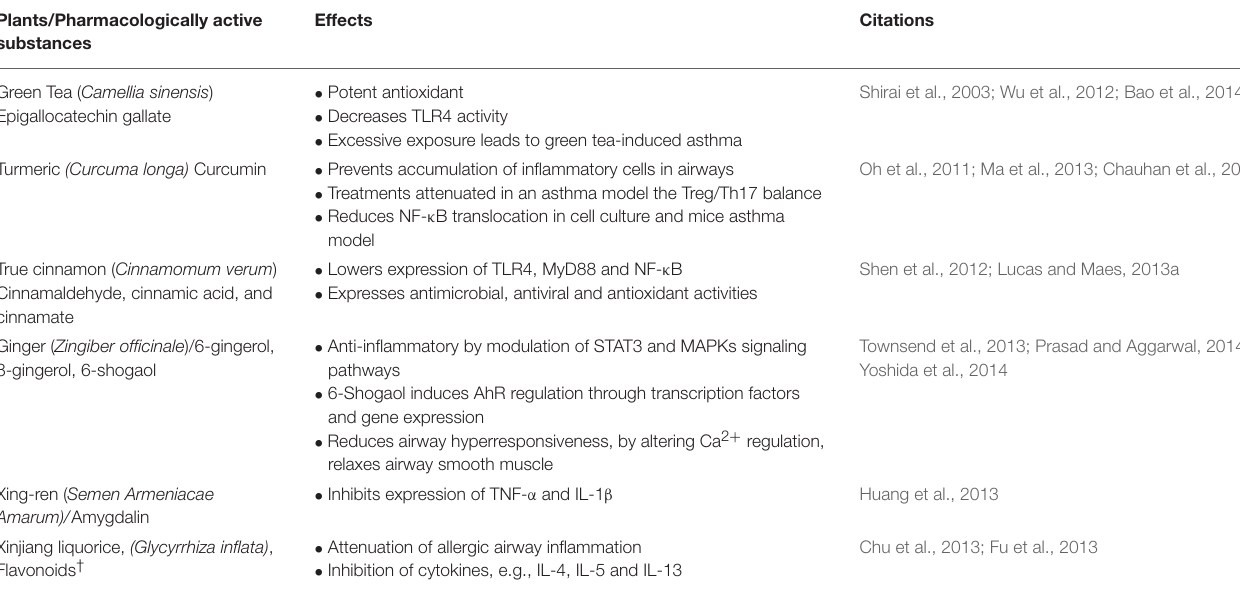
TABLE 1 | Traditional medicine with pharmacologically active substances and their effects. Plants/Pharmacologically active